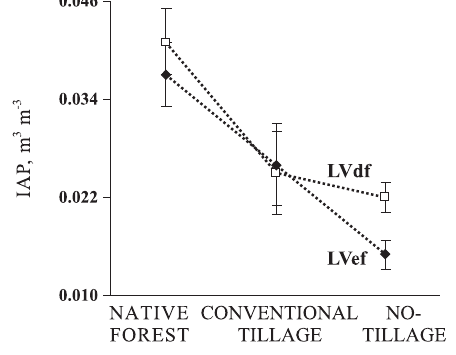
Figure 2. Average values (for 20 replications with 10 samples per profile at each sampling site) and confidence interval (95 %) for inter-aggregate porosity (IAP) of samples collected in the LVdf and LVef (dystroferric and eutroferric red Oxisols) in the 5–50 cm layer, representing the crop